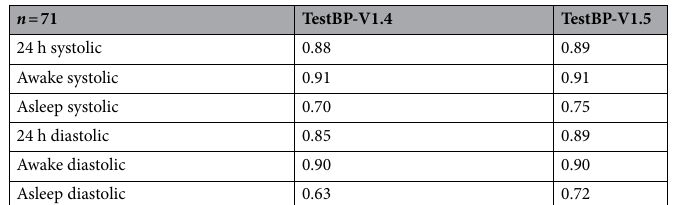
Table 3. ICC between RefBP and TestBP-V1.4 and TestBP-V1.5. Data are Intraclass Correlation Coefficiants (ICC). Values less than 0.5, between 0.5 and 0.75, between 0.75 and 0.9, and greater than 0.90 indicating poor, moderate, good, and excellent reliability, respectively 17 .